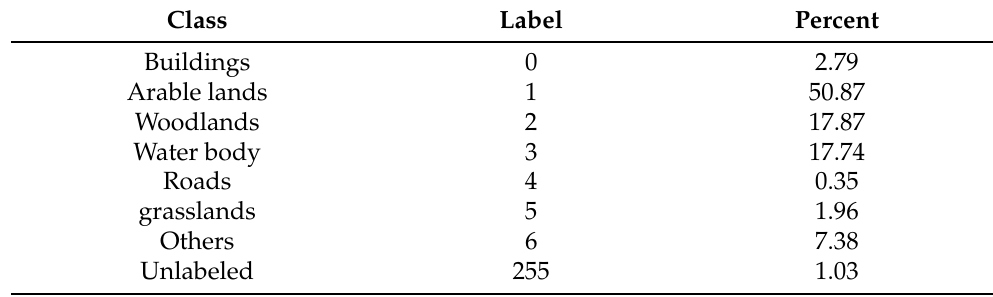
Table 1. Dataset distribution details.